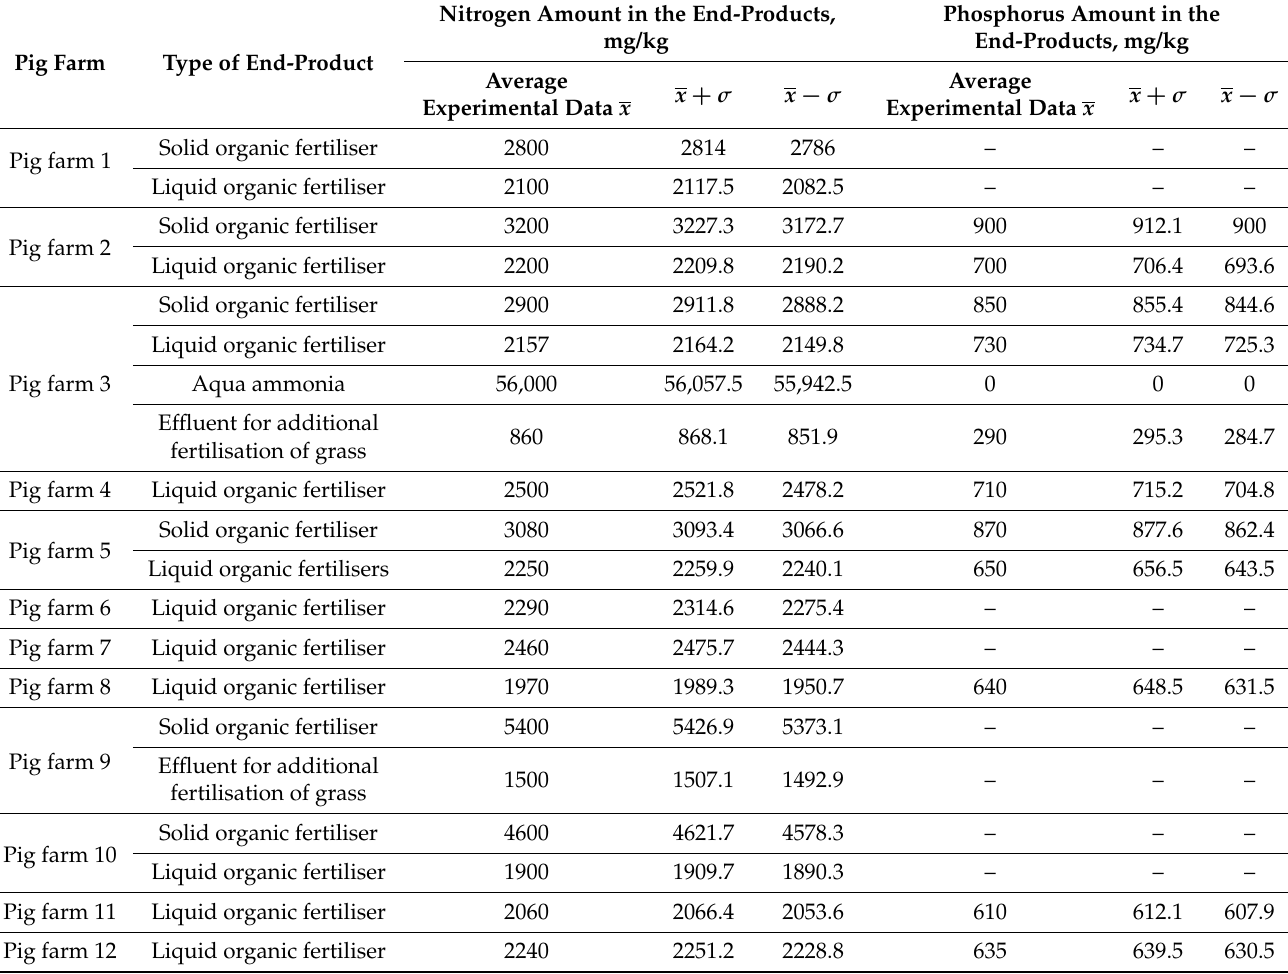
Figure 6. A balance diagram of the selected technology. Table 5. Statistical analysis of the data from the laboratory protocols on the total nitrogen and phosphorus content in the pig manure-based